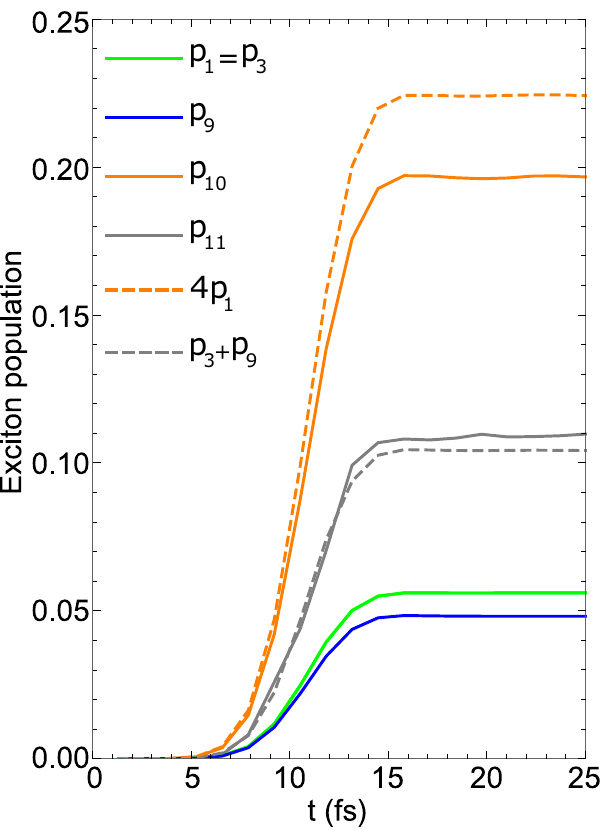
Fig. 11 Circularly polarized light to twisted exciton. Exciton populations in a 4 nm long (3, 3) CNT illuminated by right-hand circularly polarized light ( p 9 ), right-hand circularly polarized light with spin = − 1 and twisted light with PAM = − 1 of the same amplitude ( p 10 ), and right-hand circularly polarized light and twisted light with PAM = 1 of the same amplitude ( p 11 ). The CNT is initially in the ground state. The p 1 = p 3 curve is reproduced from Fig.